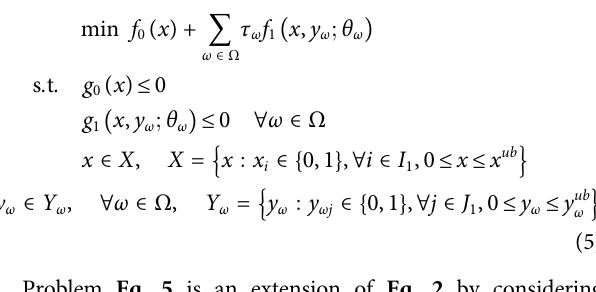
Frontiers in Chemical Engineering |